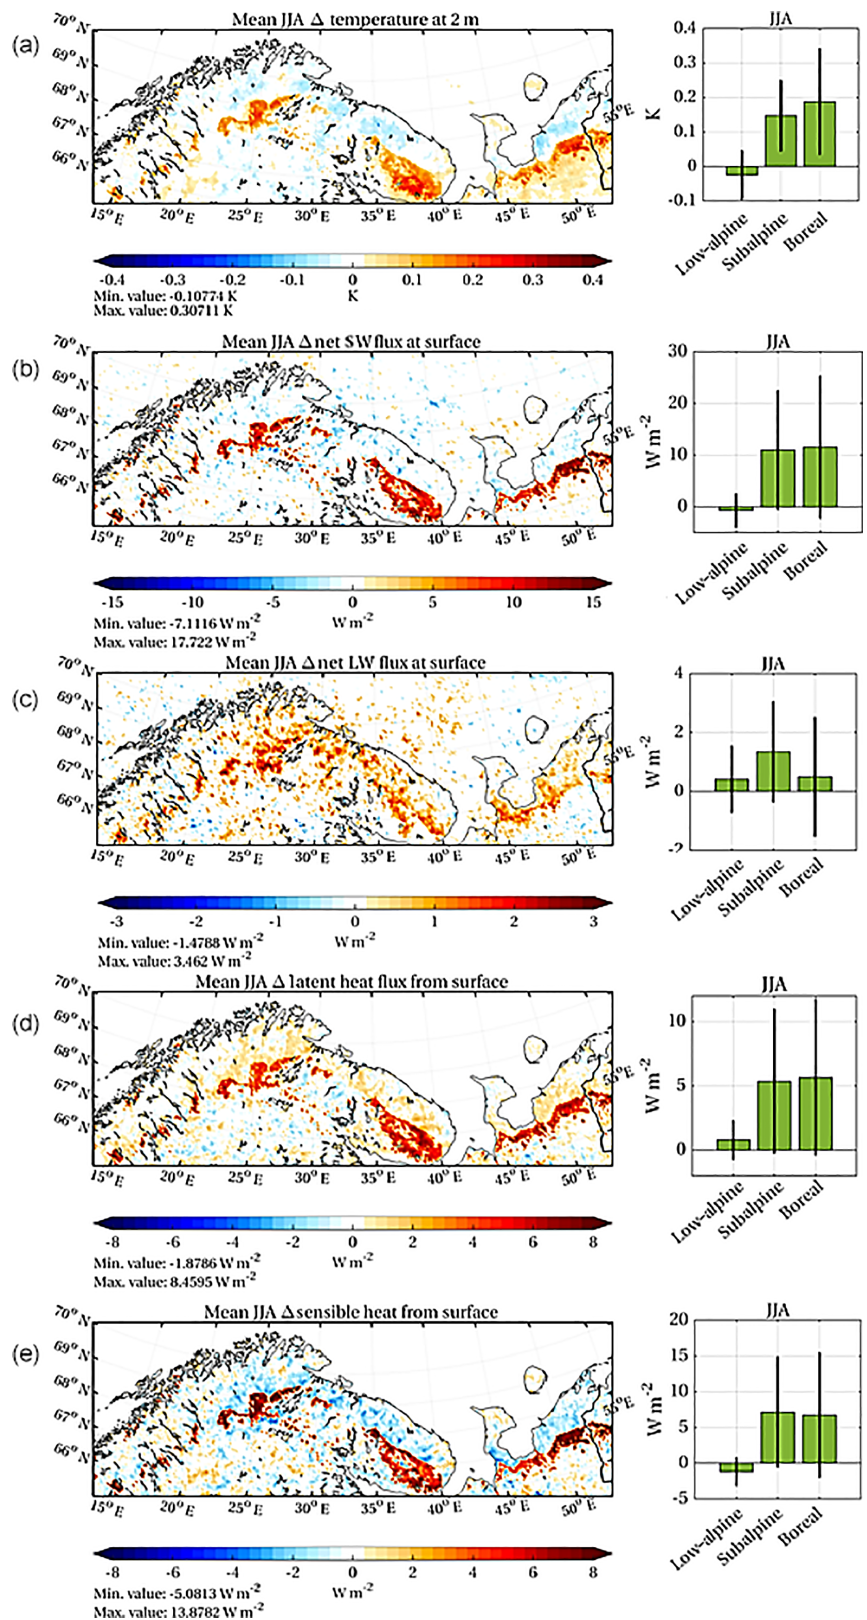
Figure 5. Effects of increased shrub cover (Veg0K–RefVeg) on the JJA season. Variables as in Fig. 4. Note that scales differ among